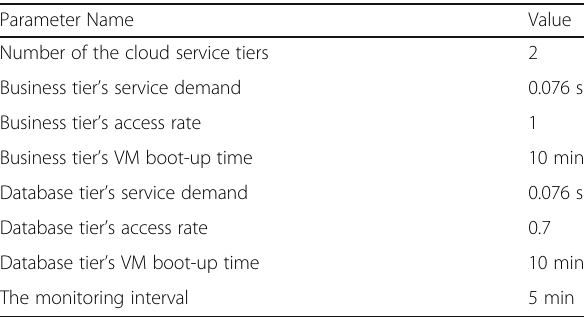
Table 1 Simulation parameters and values